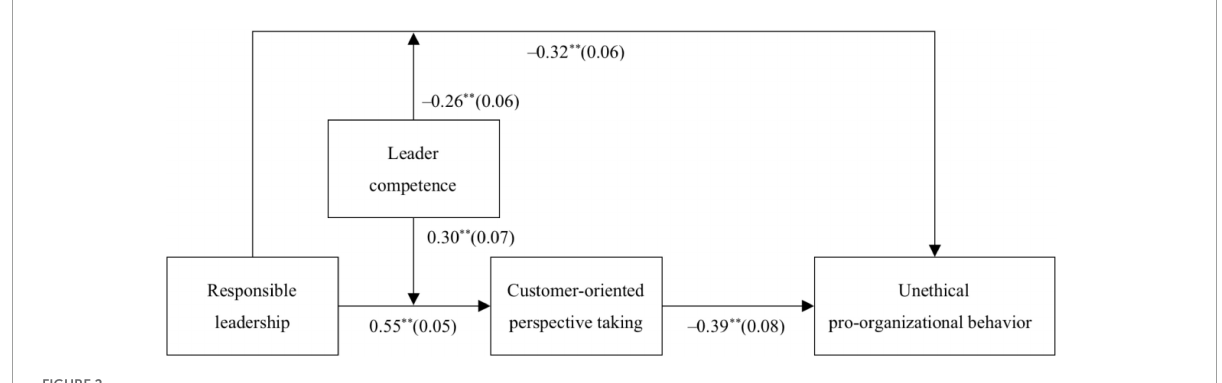
FIGURE2 The structural equation modeling path results. N = 557. Control variables were included in the model but not shown here for ease of presentation. Values in parentheses were standard error estimates. ** p < 0.01.